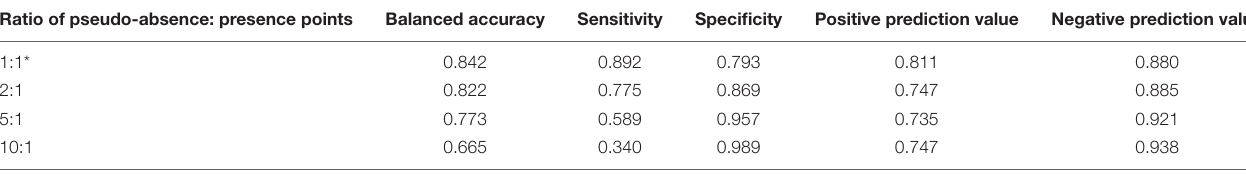
TABLE 4 | Results of the confusion matrices for GLMs created using varying ratios of pseudo-absence to presence points. Ratio of pseudo-absence: presence points